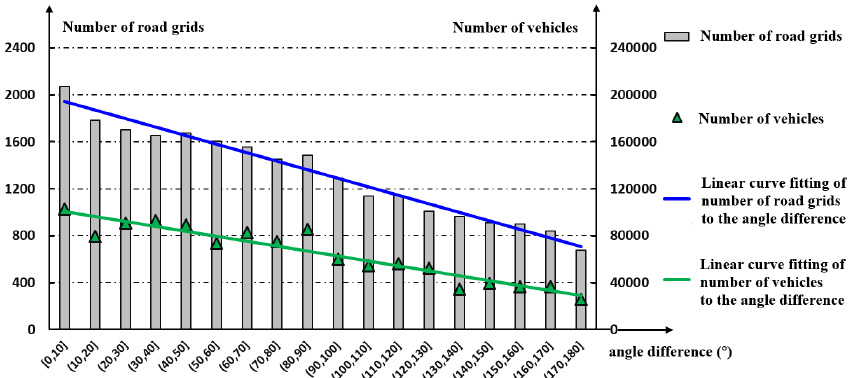
Figure 13. Correlation between the number of road grids/vehicles and the angle between the vector sum of the velocities of vehicles at the road grids and the vector sum of the directions of the electric field at that same road point ( | δθ | ).